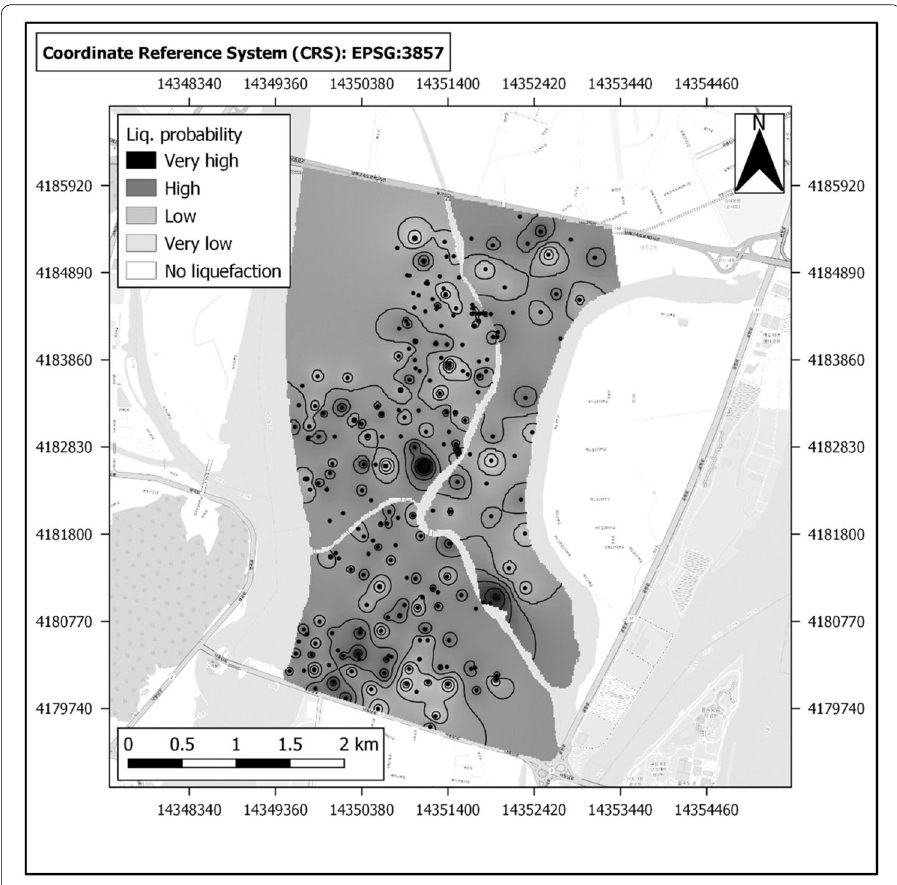
Fig. 20 Liquefaction hazard map based on OCDI [9] method for case